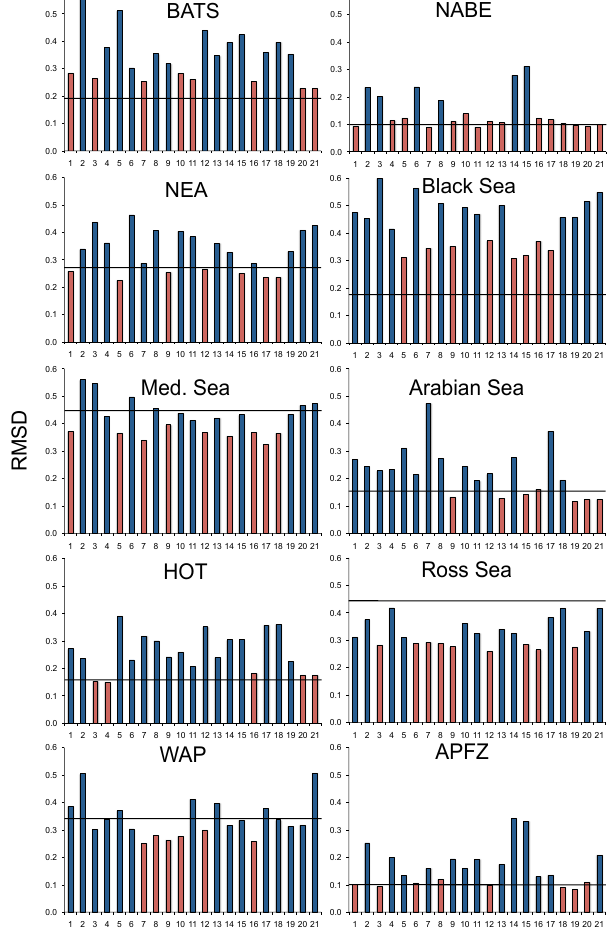
Fig. 3. Model skill (RMSD) for each model at each region. Solid black line is the RMSD when using the mean of the observed data. Models that have a RMSD below the solid black line have a Model Efficiency > 0 thus they estimate NPP more accurately than using the mean of the observed data.